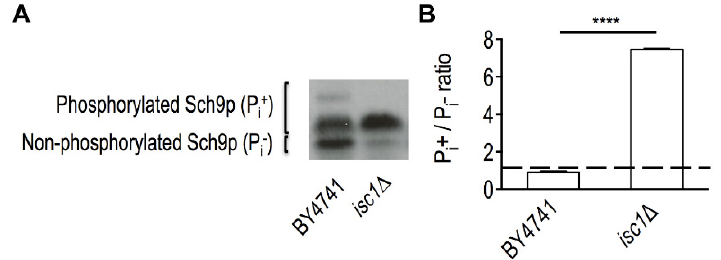
FIGURE 1: Isc1p-deficient cells exhibit enhanced TORC1 activity in vivo. The TORC1-dependent C- terminal phosphorylation of Sch9p was used to assess TORC1 activity in vivo . (A) S. cerevisiae BY4741 and isc1 Δ cells transformed with pJU676 (expressing SCH9-5HA ) were grown in SC-medium to the expo- nential phase and NTCB-treated protein extracts were analyzed by immunoblotting using anti-HA antibody, as described in Materials and Methods . A representa- tive blot out of three is shown. (B) Quantification of band intensities was performed by densitometry. The ratio between phosphorylated and unphosphorylated Sch9p (P i+ /P i- ) is shown. Values are mean ± SD of at least three independent experiments. ****p<0.0001. The results show that Sch9p is hyperphosphorylated in isc1 Δ mutants when compared to parental cells, indicative of increased TORC1 activity (Fig. 1A-B). Apart from TORC1, Sch9p can also be phosphorylated by Pkh1/2p in response to LCBs. Since basal levels of phytosphingosine (PHS) are increased in isc1 Δ cells during aging [17], we also assessed the Pkh1/2p-dependent phosphorylation of Sch9p on the Thr570 residue. The results show that the levels of Sch9p- phospho-Thr570 were similar in parental and isc1 Δ cells (Supplementary Fig.